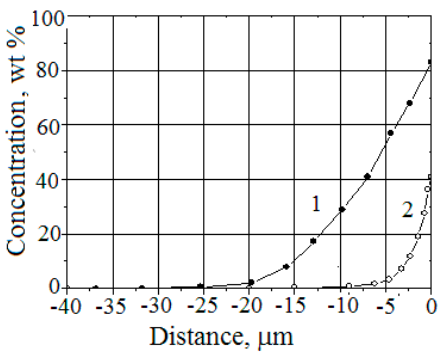
Figure 5. The lead content in the aluminum layer of the ingot (1) without treatment and (2) after EMP processing (the zero coordinate is the visible boundary between the lead and aluminum).